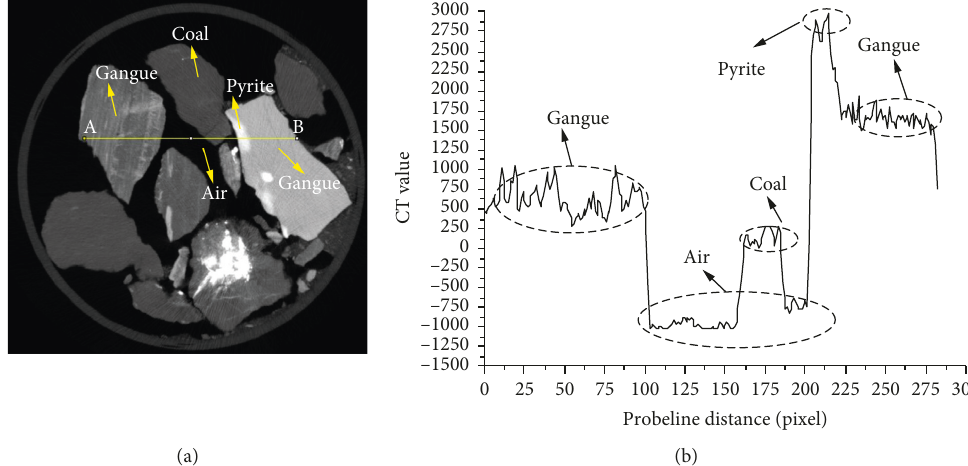
Figure 2: Variation of CTvalues of the sectioned 2D images along the probeline AB cutting are shown to reveal detailed information of the packed samples. This figure (a) presents the line-probe path AB and (b) presents the variation of CT values along